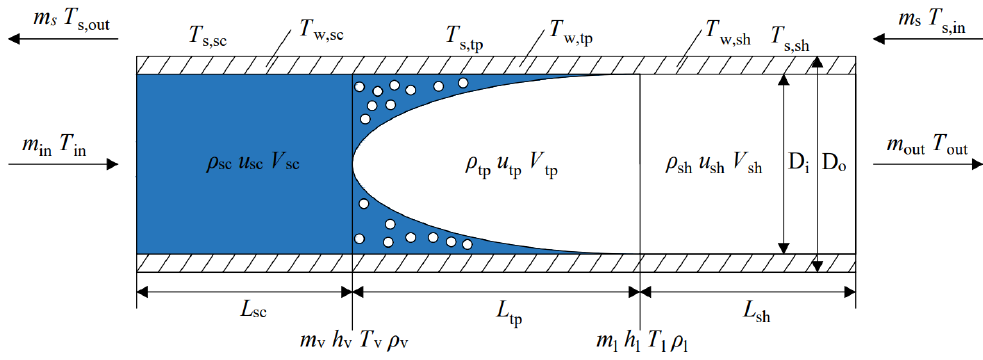
Figure 3. Schematic diagram of the evaporator moving boundary model.